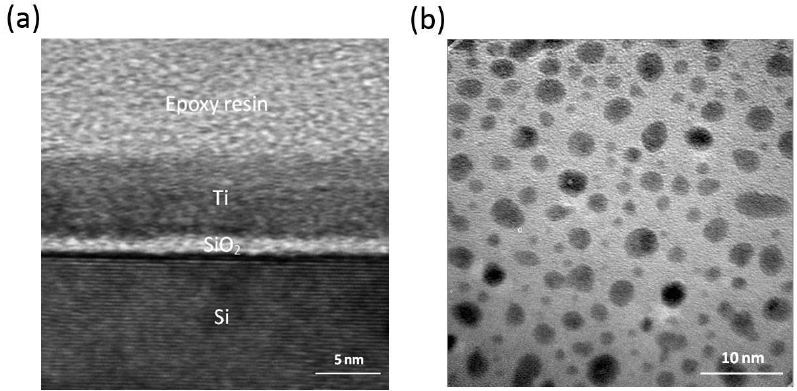
Figure 2. (a) A cross-section TEM image of the calibration MOS structure (1.2 nm)/Si. (b ) TEM planar-view image of the top polycrystalline Ti of Ti(6.2 nm)/SiO 2 film of the